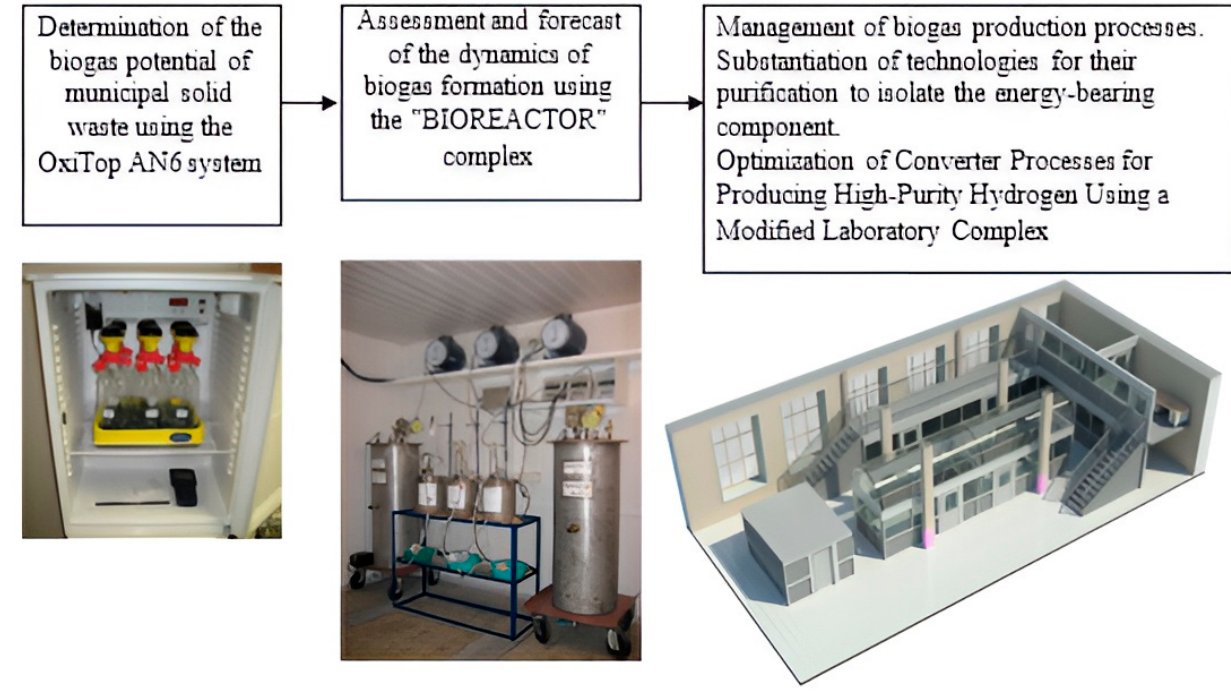
Figure 1. Scheme of a multi-stage laboratory experiment.